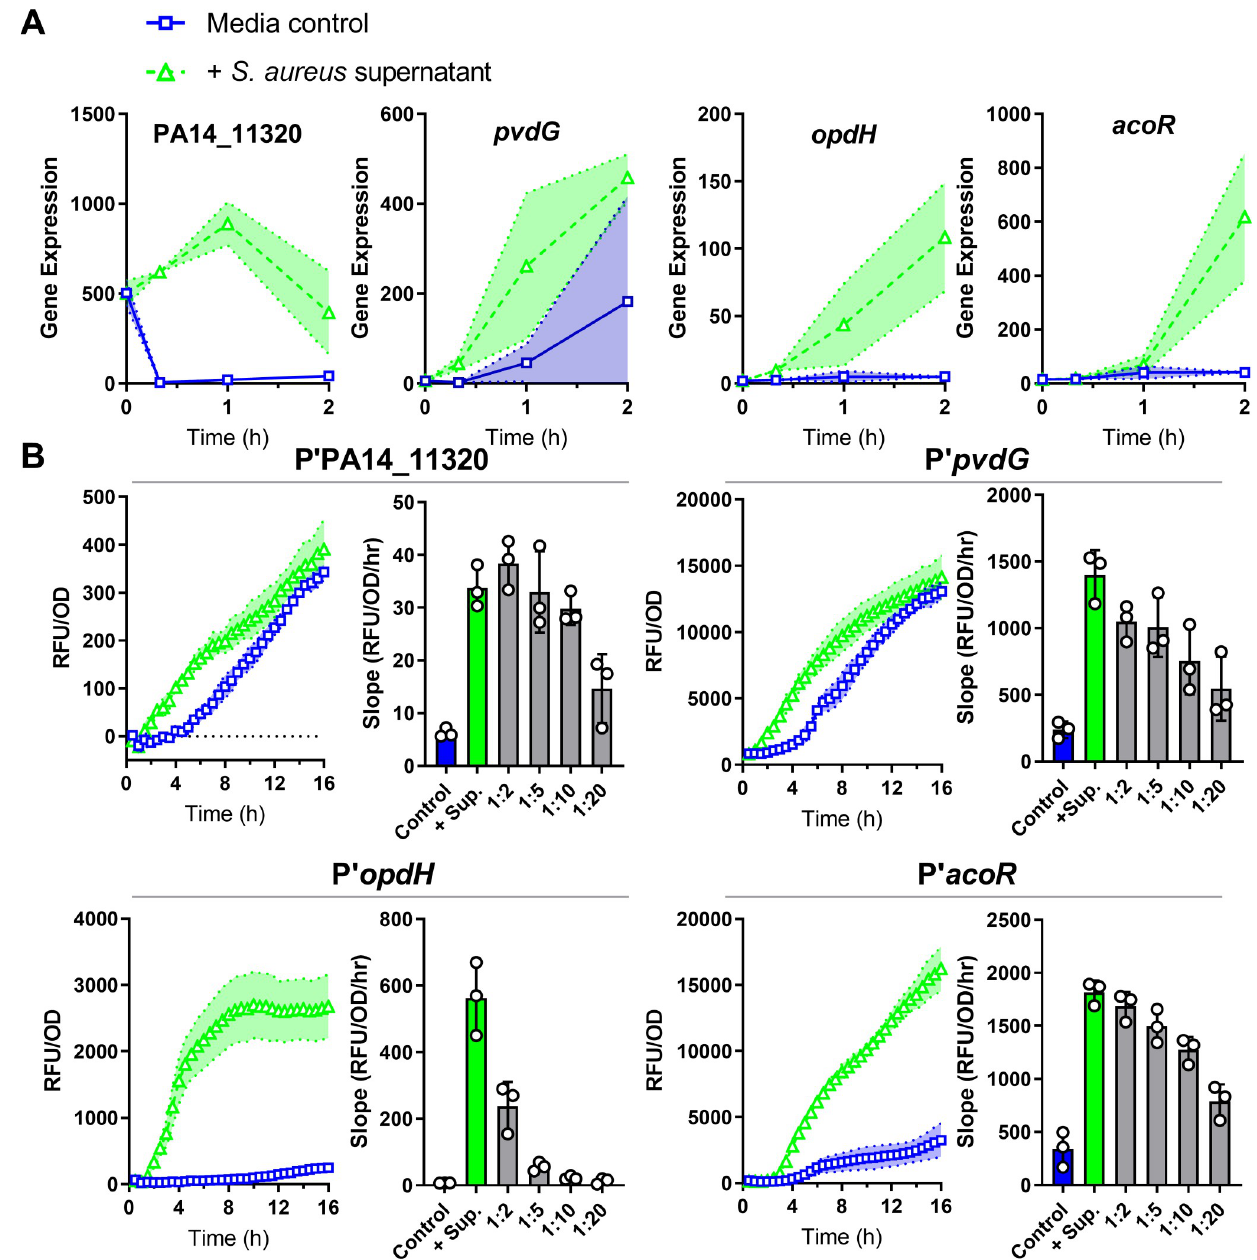
Fig 2. P . aeruginosa promoter-reporters are induced by S . aureus exoproducts. (A) Expression levels from P . aeruginosa RNA-seq after exposure to S . aureus supernatant or media control for four transcripts as gene candidates for promoter-reporter construction. Gene annotations: PA14_11320, Zur- regulon putative lipoprotein in operon with ABC transporter; pvdG , pyoverdine biosynthesis thioesterase; opdH , TCA uptake porin; acoR , transcriptional regulator of acetoin catabolism genes. (B) RFUs of mScarlet normalized to OD 600 over time after exposure to S . aureus supernatant or media control in the indicated promoter-reporter strains. Slope calculated from 1.5 to 5 hours (promoters of PA14_11320, opdH , and acoR ) or 1 to 4 hours (promoter of pvdG ) after addition of supernatant, supernatant dilutions, or media control. Each strain had higher expression of mScarlet after supernatant addition compared with media control and displayed dose-dependent responses. Shaded regions and error bars show the SD. The data underlying panels A and B can be found in Table A in S1 File and S1 Table, respectively. RFU, relative fluorescence unit; RNA-seq, RNA sequencing; SD, standard deviation.